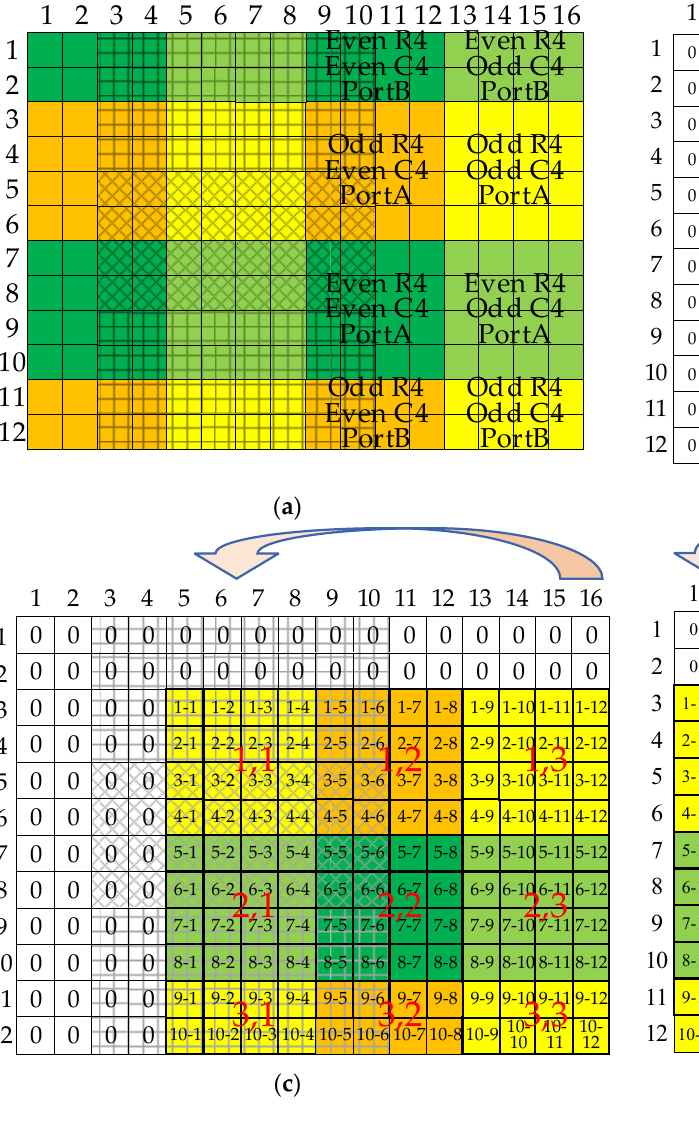
Figure 8. Data temporal & spatial reuse and padding of IFM buffer: ( a ) How IFM buffer works when kernel size is 5 × 5, stride is 1; ( b ) clock 0; ( c ) clock 1; ( d ) clock 2.